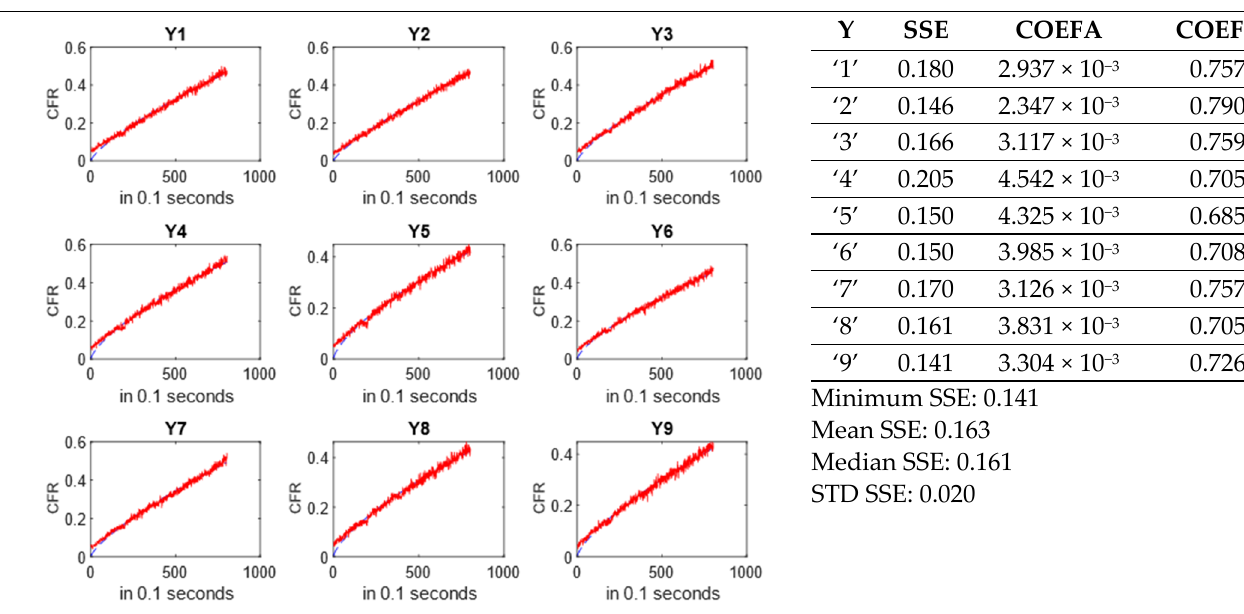
Figure 6. Output report displaying SSE values and model coefficients for albumin at 20 kHz (6.2 mW/cm 2 ) using